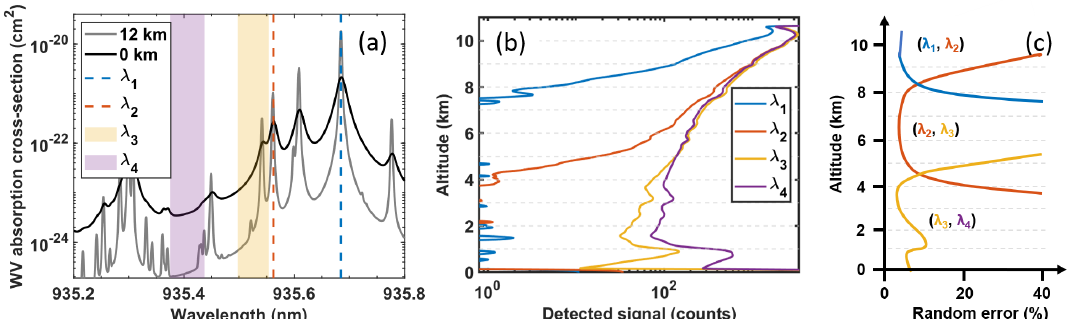
Figure 1. (a) Voigt spectrum of WV absorption cross section at 12km (210hPa, 22K) and at sea level (1013hPa, 300K), with vertical lines and shading indicating the fixed and tunable HALO wavelengths. (b) Example profile of HALO measured signals for the four transmitted wavelengths, averaged temporally and vertically to match a typical final WV product resolution (60s temporal, 315m vertical). (c) Sensitivity of line pairs to different parts of the atmosphere, expressed as an estimation of random error versus altitude. Line pairs are in parentheses as (online, offline). Error magnitudes can change with retrieval resolution, as discussed in Sect. 4.1, though the general line shape versus altitude will remain. Table 1. HALO parameters. Transmitter type Custom Fibertek Nd:YAG pumped OPO Wavelengths 532, 935,